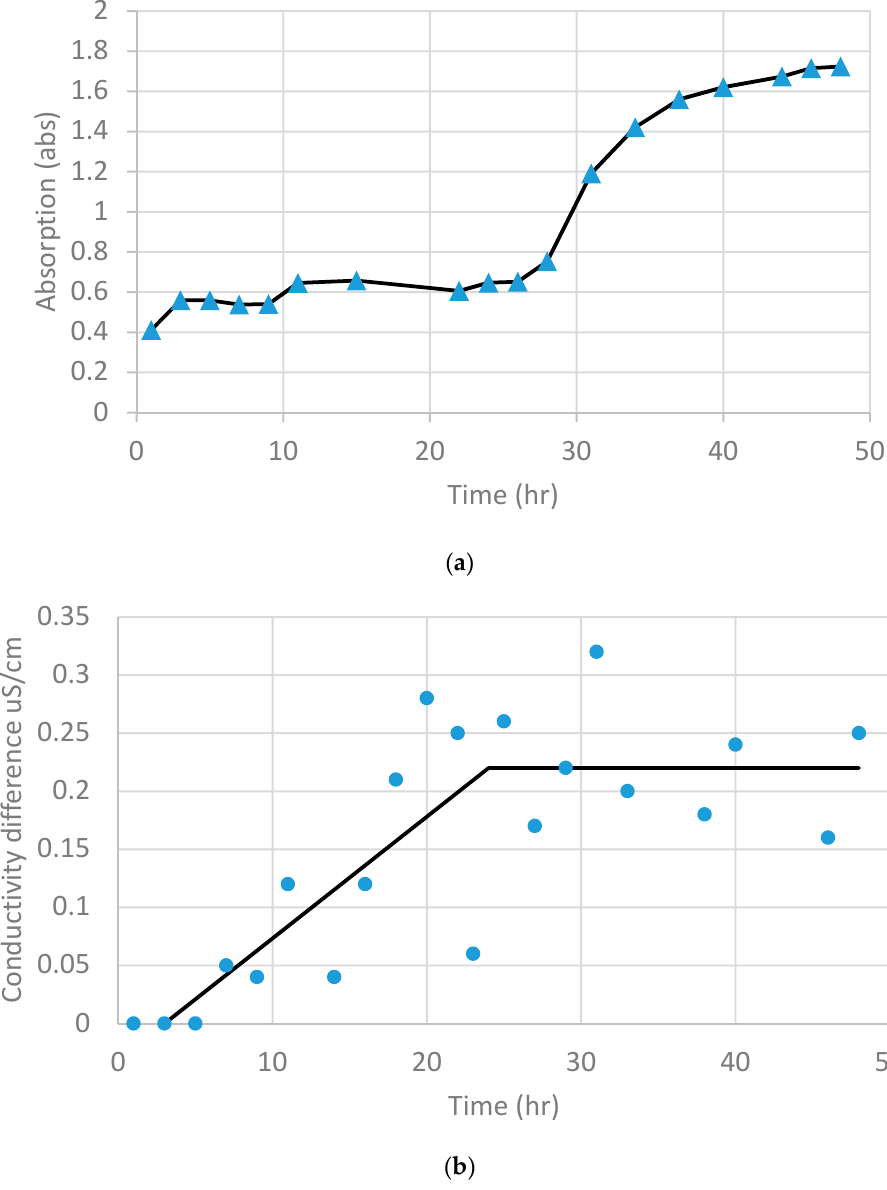
Figure 1. Experimental characterization of bacteria concentration and activity: ( a ) absorption (OD600) measured from spectrophotometer; ( b ) increase in electrical conductivity measured from the electric conductometer.